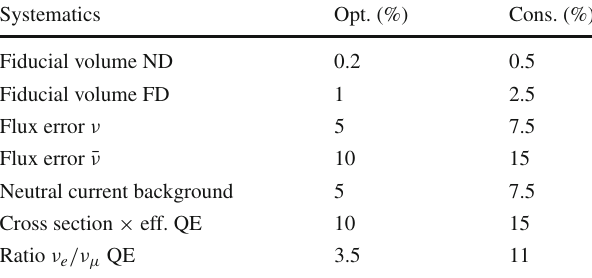
Table 1 Systematic uncertainties for a super beam as described in Ref. [39] for two different scenarios, the “Optimistic” one and the “Conser- vative” scenario where systematics are larger Systematics Opt. (%) Cons.